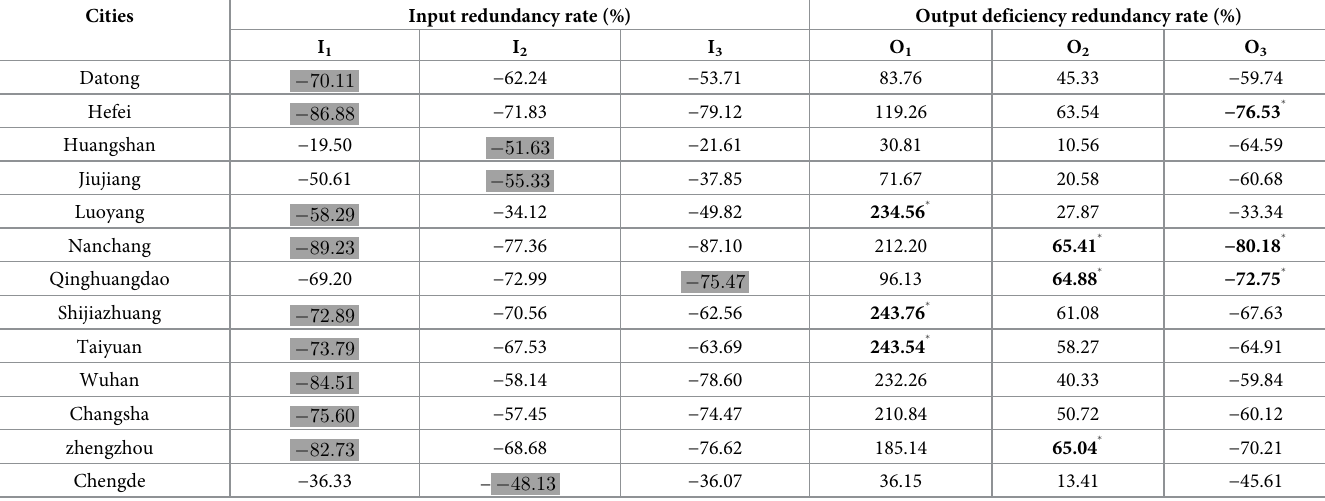
Note: In Table 3, I 1 refers to investment in fixed assets, I 2 refers to employees in the tertiary industry, I 3 refers to foreign direct investment, O 1 refers to total tourism income, O 2 refers to total tourism population and O 3 refers to PM2.5 emission concentration. 1) The negative number in the table represents that this indicator is redundant, and the positive number represents that this indicator is insufficient. Redundancy (deficiency) rate refers to the absolute value of the corresponding value of each indicator. 2) The dark colour blocks in the table represent the indicator ranking first in the redundancy rate. 3) The figures with ‘ � ’ in the output indicators correspond to the cities in the top three of deficiency (redundancy)